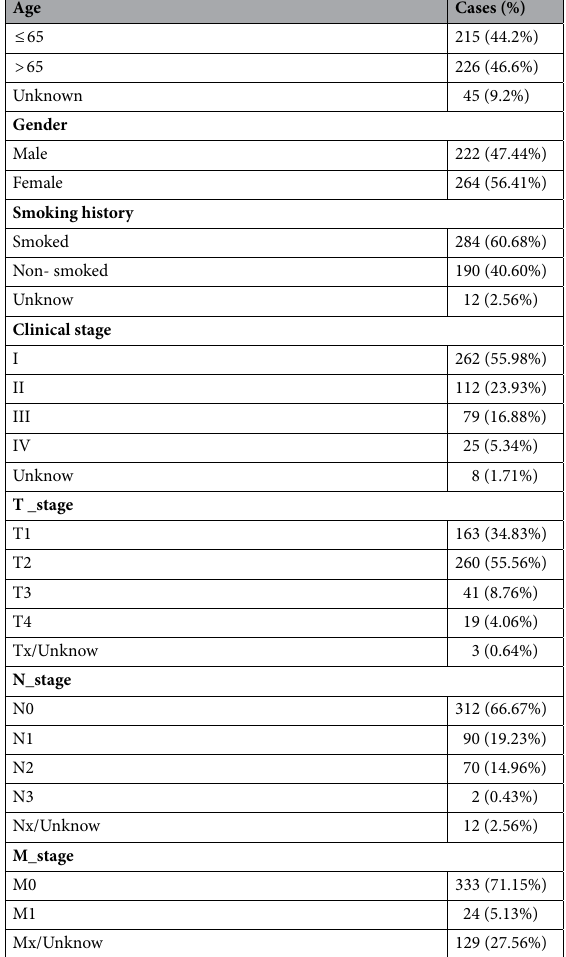
Table 1. Clinicopathological characteristics of patients in TCGA lung